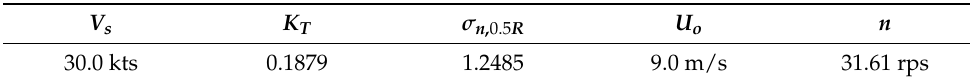
Table 2. LCT test conditions for cavitating